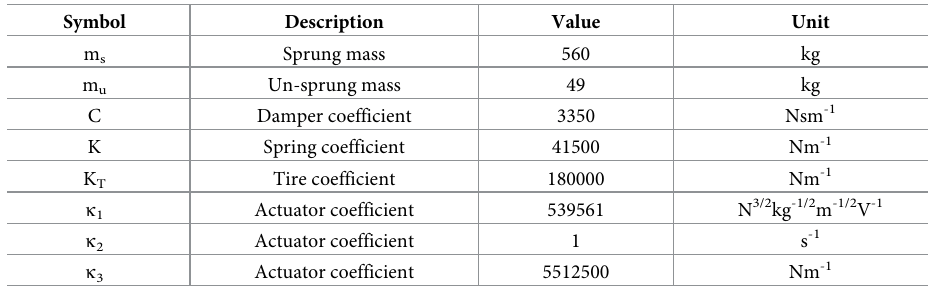
Table 1. Vehicle